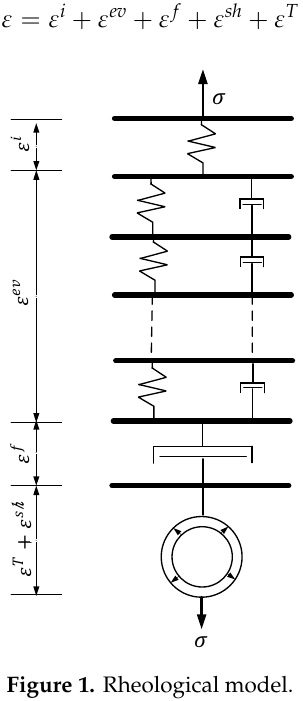
Figure 1. Rheological model.